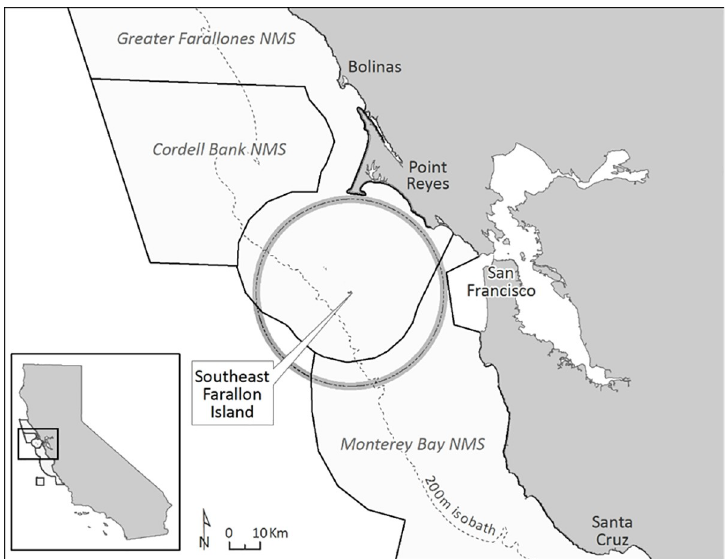
Fig 2. Map of the study area located off the coast of central California showing the location of Southeast Farallon Island and the 30km sight range. The Greater Farallones, Cordell Bank, and Monterey Bay National Marine Sanctuaries (NMS), which border the central California coast are outlined. The 200m isobath is depicted by the dashed line.